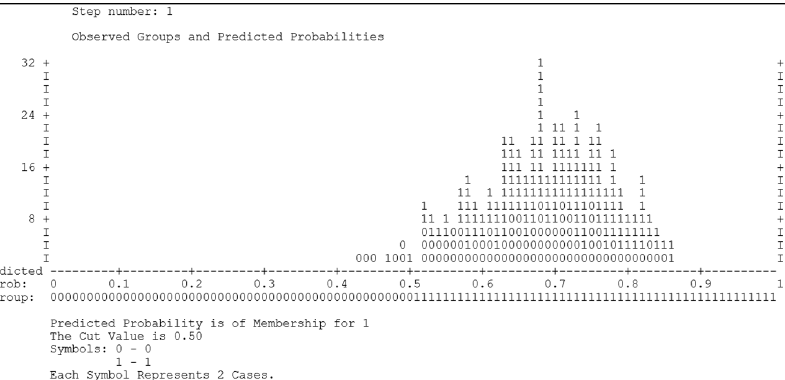
Figure 11. Observed groups and predicted probabilities.